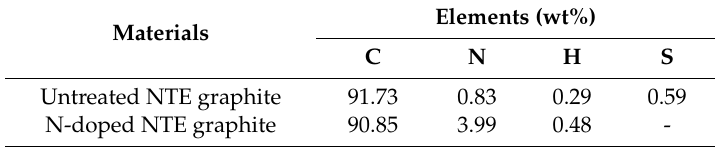
Table 2. Elemental composition of untreated NTE graphite and N-doped NTE graphite.